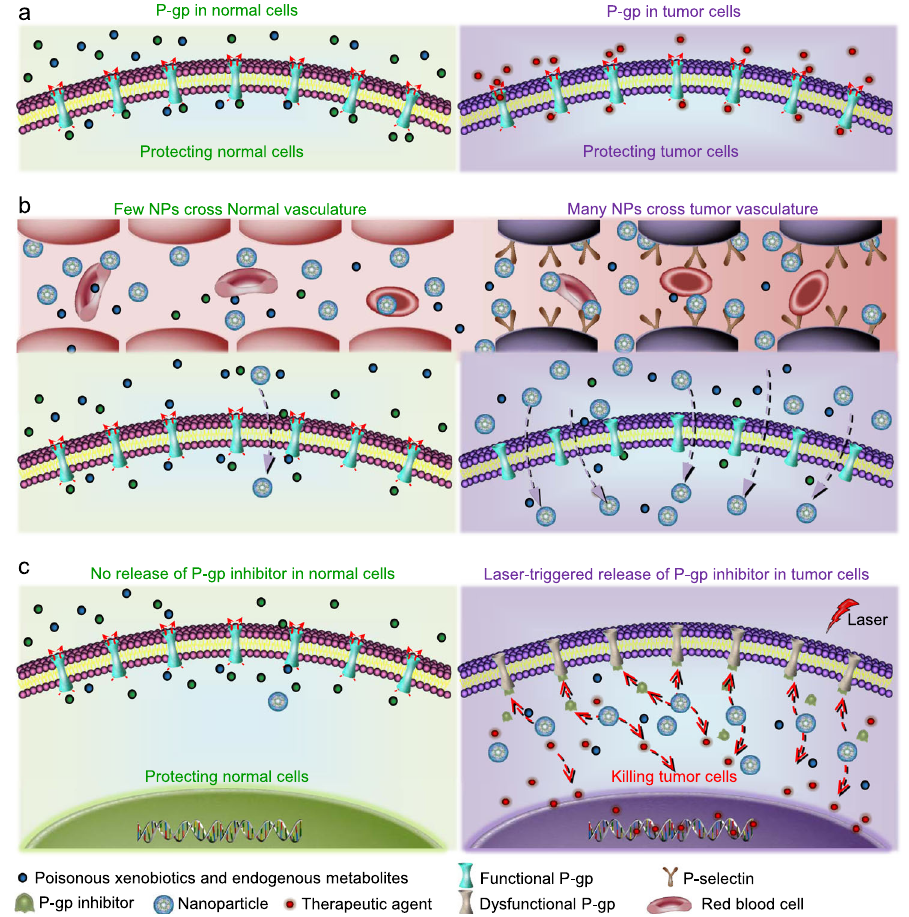
Fig. 1 A schematic illustration of the strategy for targeting tumor vasculature and inhibiting the ef fl ux pumps in drug-resistant tumor. a